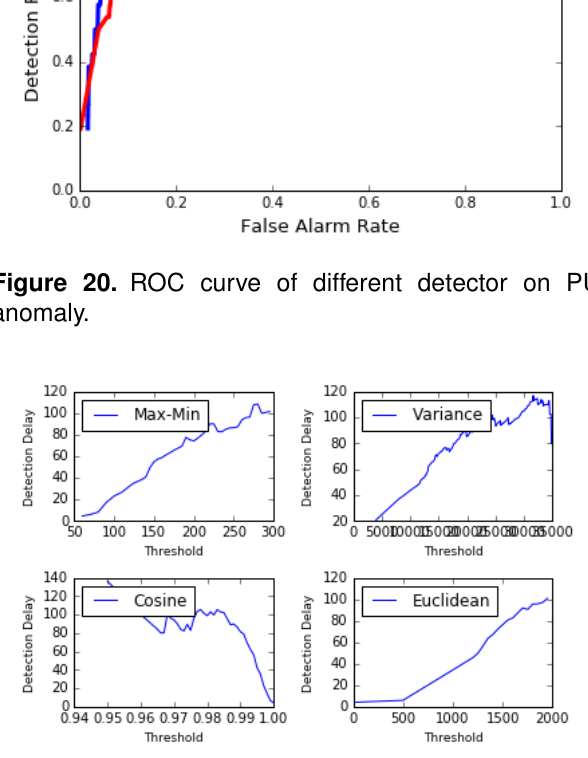
Figure 21. Detection delay of different detector on PUE attack (in seconds).